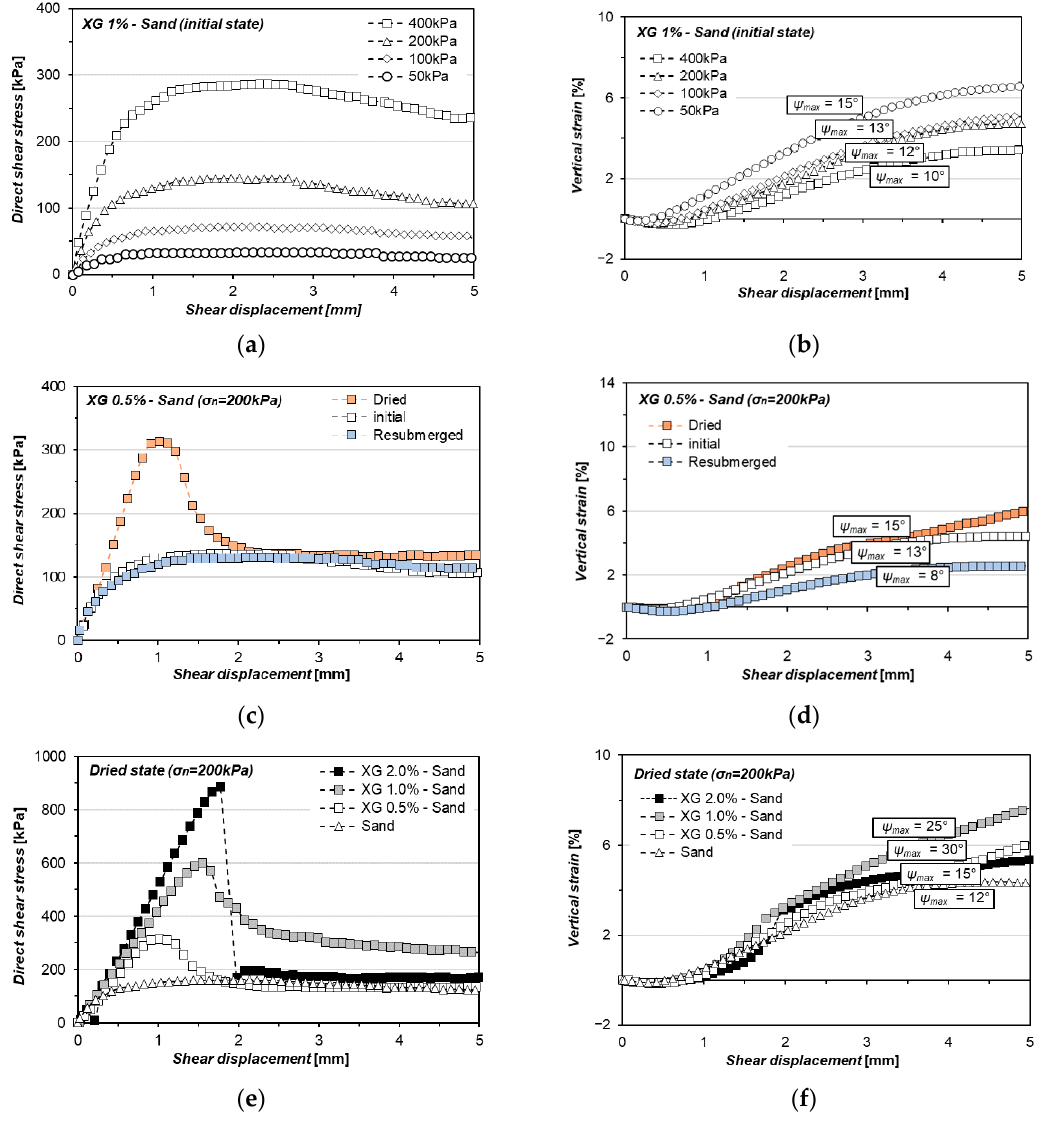
Figure 5. Direct shear test results of xanthan gum-treated soil: ( a , c , e ) direct shear stress ( τ )-horizontal shear displacement ( δ ) curves; ( b , d , f ) vertical strain ( ε v )-horizontal shear displacement ( δ ) curves.